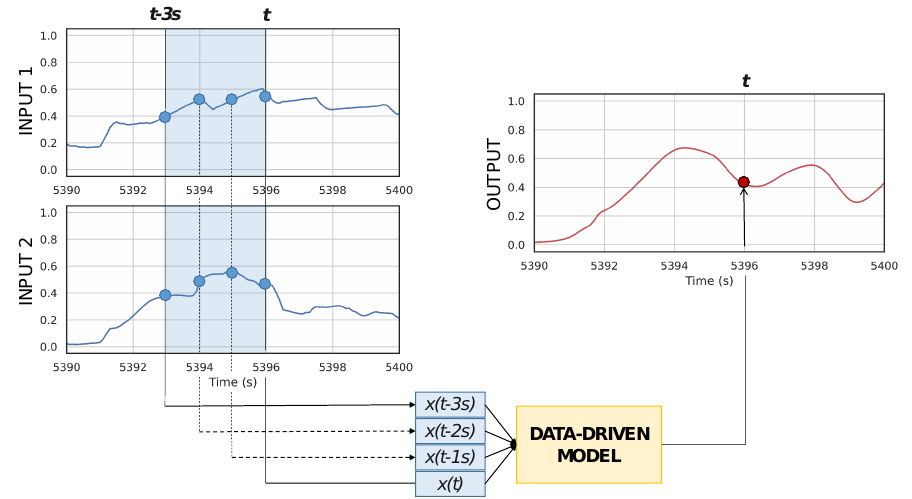
Figure 10. Sliding Window techniques, considering 3 s-sized window.